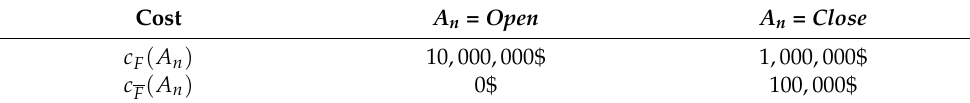
Table 3. Cost of bridge failure and survival depending on the selected action.